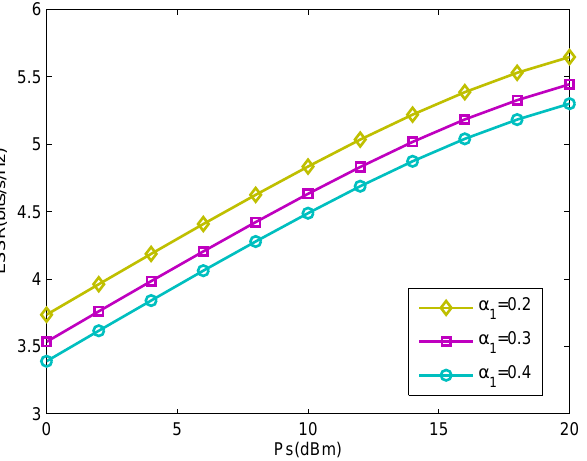
Figure 5. ESSR versus the whole transmit power P s with different U 1 ’s power allocation ratios α 1